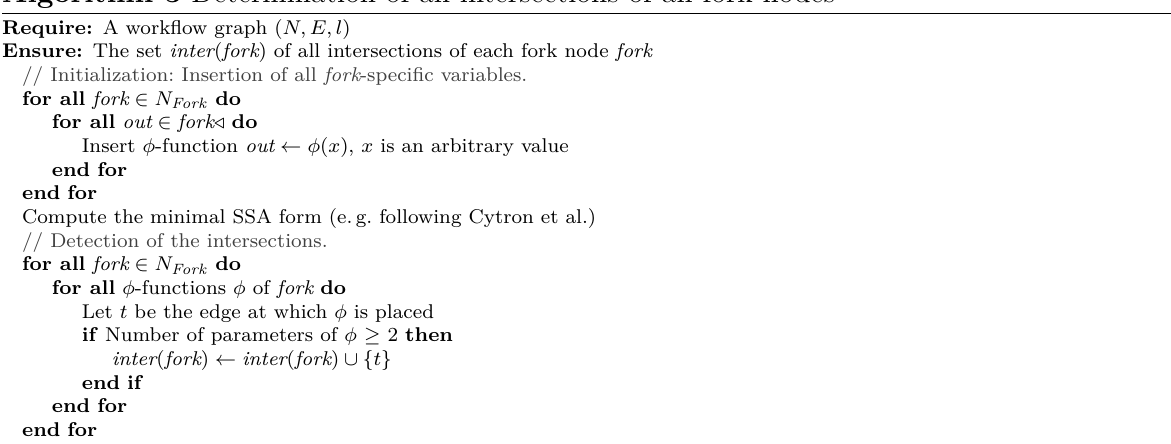
Algorithm 3 Determination of all intersections of all fork